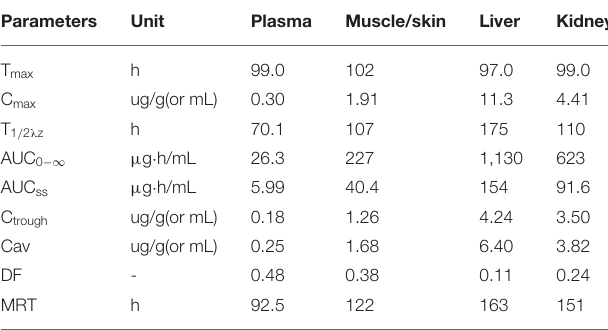
TABLE 4 | Pharmacokinetic parameters of ciprofloxacin in the plasma and tissues of crucian carp after oral administration of multiple doses (20 mg/kg b.w., for five consecutive doses, with an interval of 24h between each dose) at 28 ◦ C (Time from the first dose).